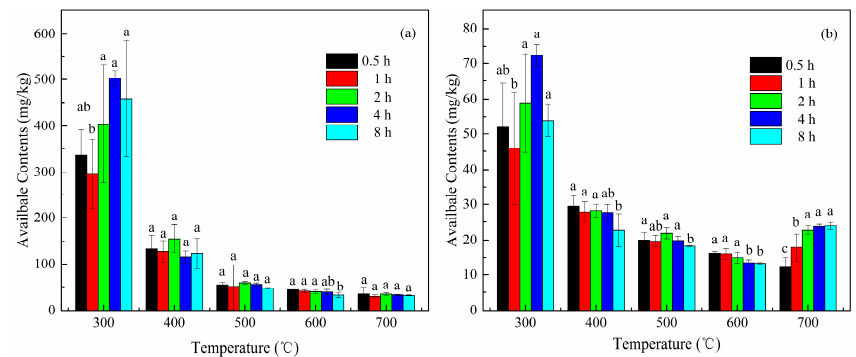
Figure 1. Effects of different temperatures and time on stabilization of zinc ( a ) and copper ( b ) in soils during calcination. Different letters indicate significant difference ( p ≤ 0.05) between treatments of different calcination time at the same temperature.